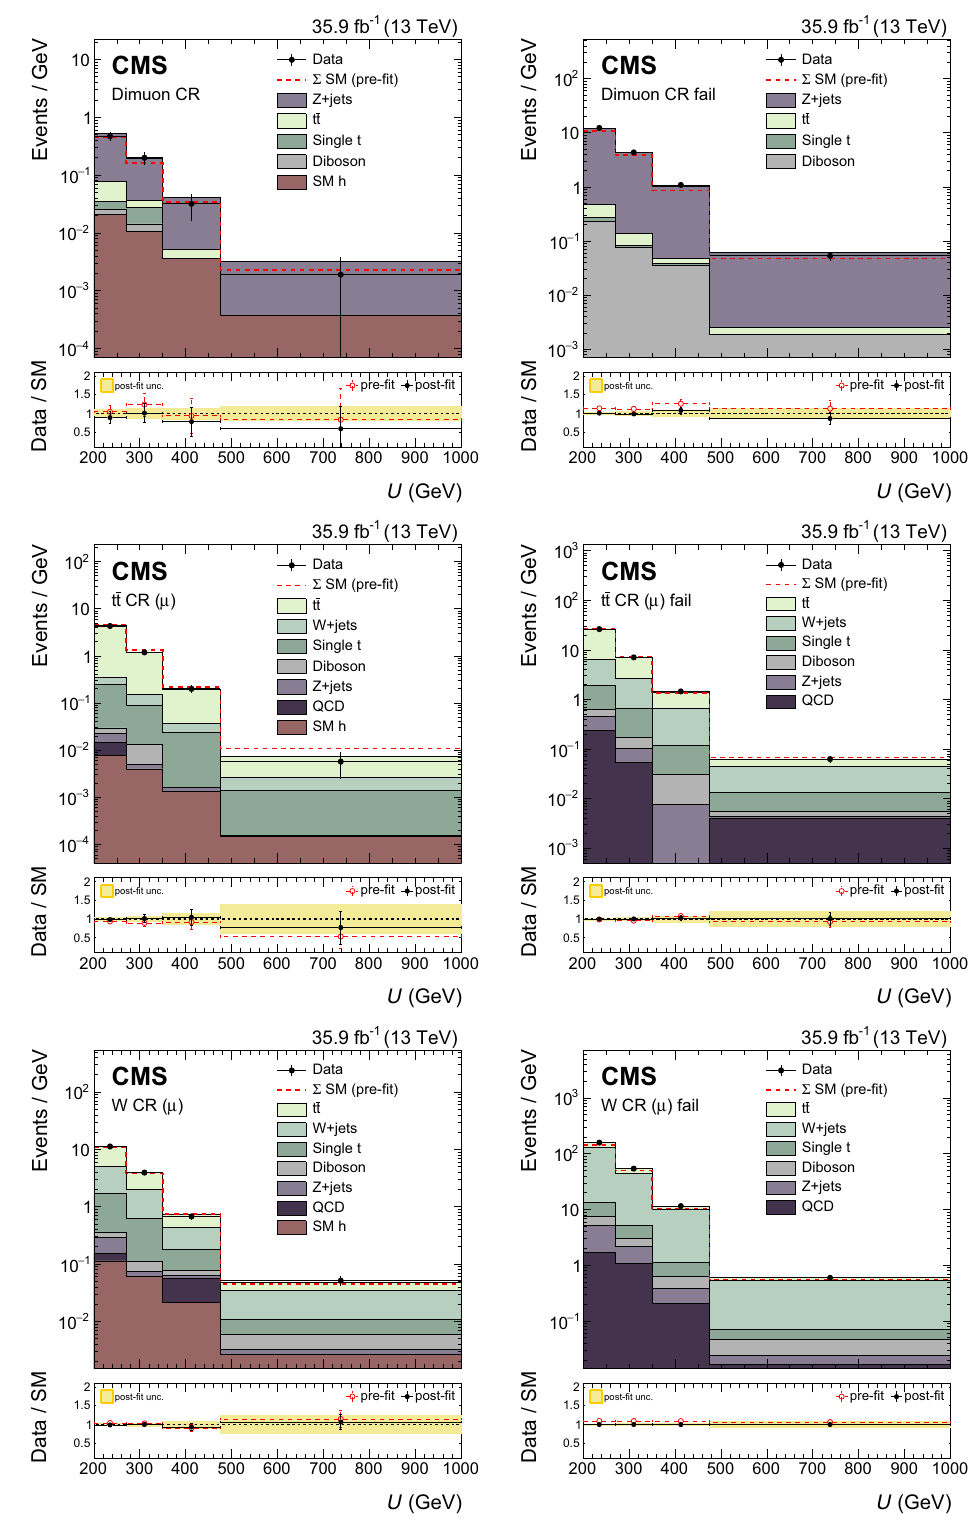
Fig. 5 The U distribution in the muon control regions before and after a background-only fit to data, including the data in the signal region in the likelihood. For the distributions on the left the CA15 jet passes the double-b tag requirement and for the distributions on the right it